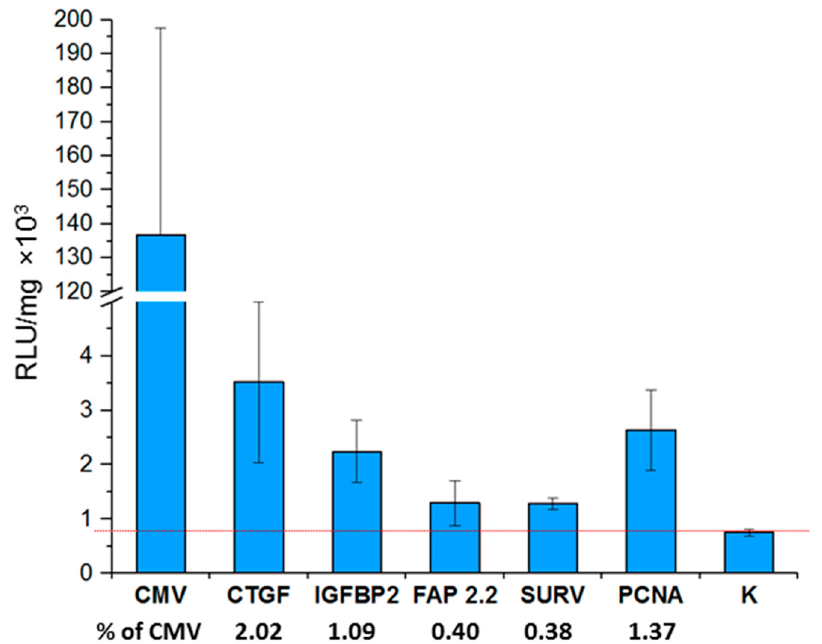
Figure 6. Relative promoter activities of the studied promoters in mouse CMT 167 tumors. The graph represents relative promoter activities (Y-axis) as ratios of the luciferase activity expressed by plasmids containing promoters under the study normalized to milligram of protein. The Y-axis serifs designate scale breaks. The numbers under the names of promoters indicate the activity of promoters in tumors relative to the activity of the CMV promoter. The measurements were performed in 3–4 technical replicates for each sample and are represented as mean ± s.e.m. RLU/mg—relative light units per milligram of protein.